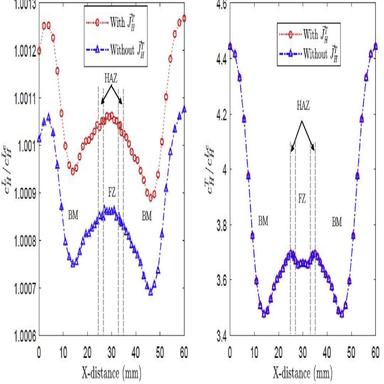
The normalized lattice cL H∕cLe H (on the left) and trapping cT H ∕cLe H (on the right) hydrogen concentration with and without J⃖⃗T .